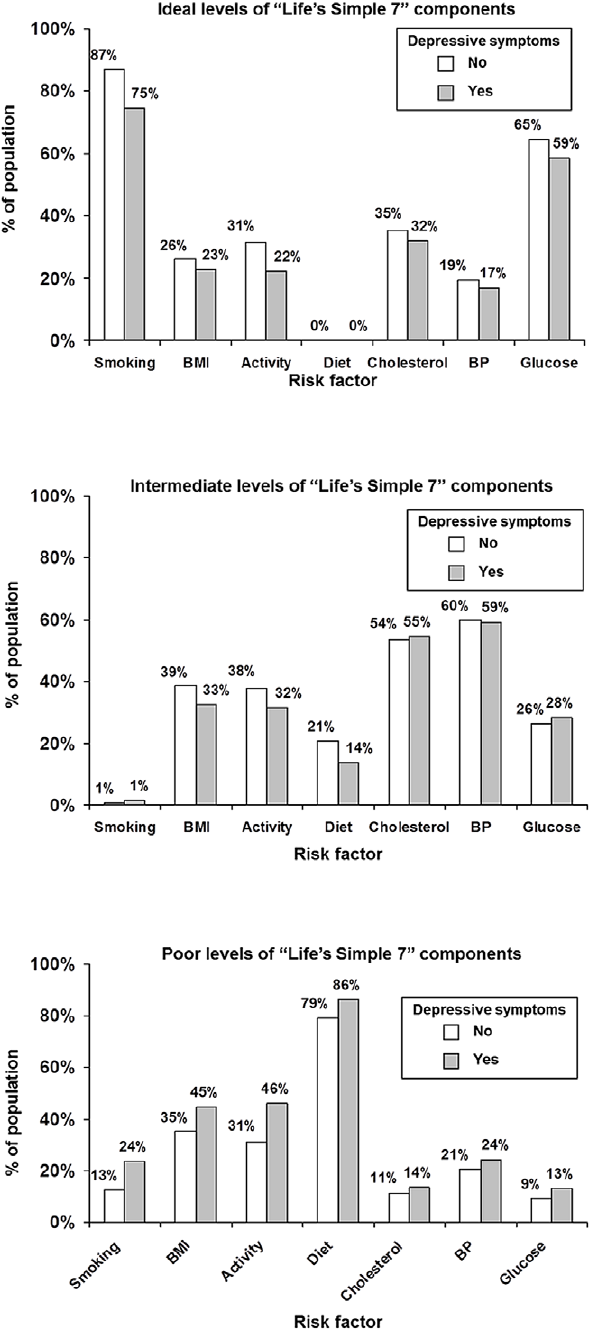
Figure 1. Distribution of Life’s Simple 7 Components as Ideal, Intermediate and Poor Among REGARDS Participants With and Without Elevated Depressive Symptoms a . a Depressive symptoms were defined as a score $ 4 on the 4-item Center for Epidemiologic Studies Depression Scale.